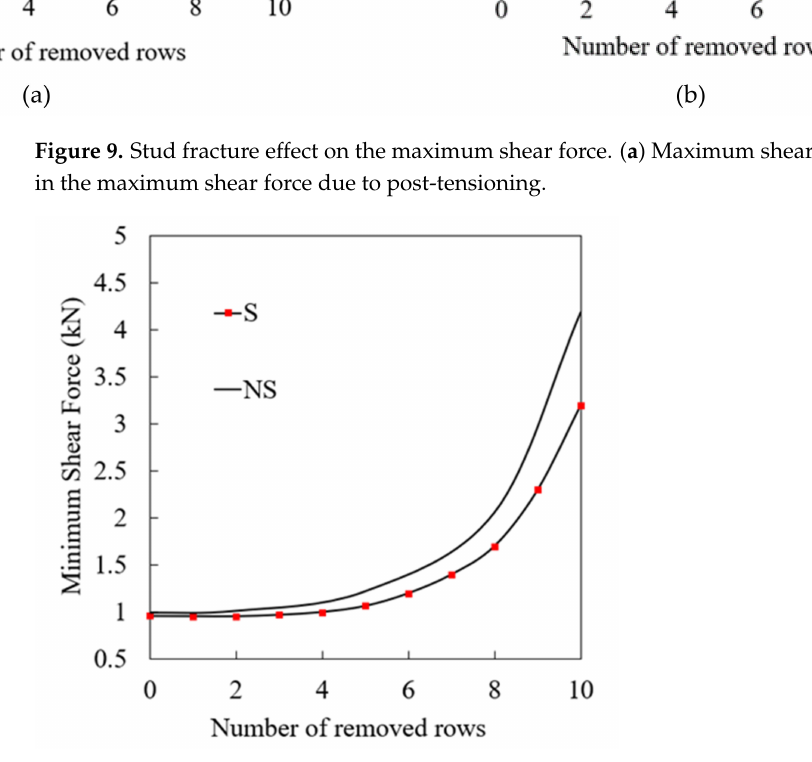
Figure 10. Stud fracture effect on the minimum shear